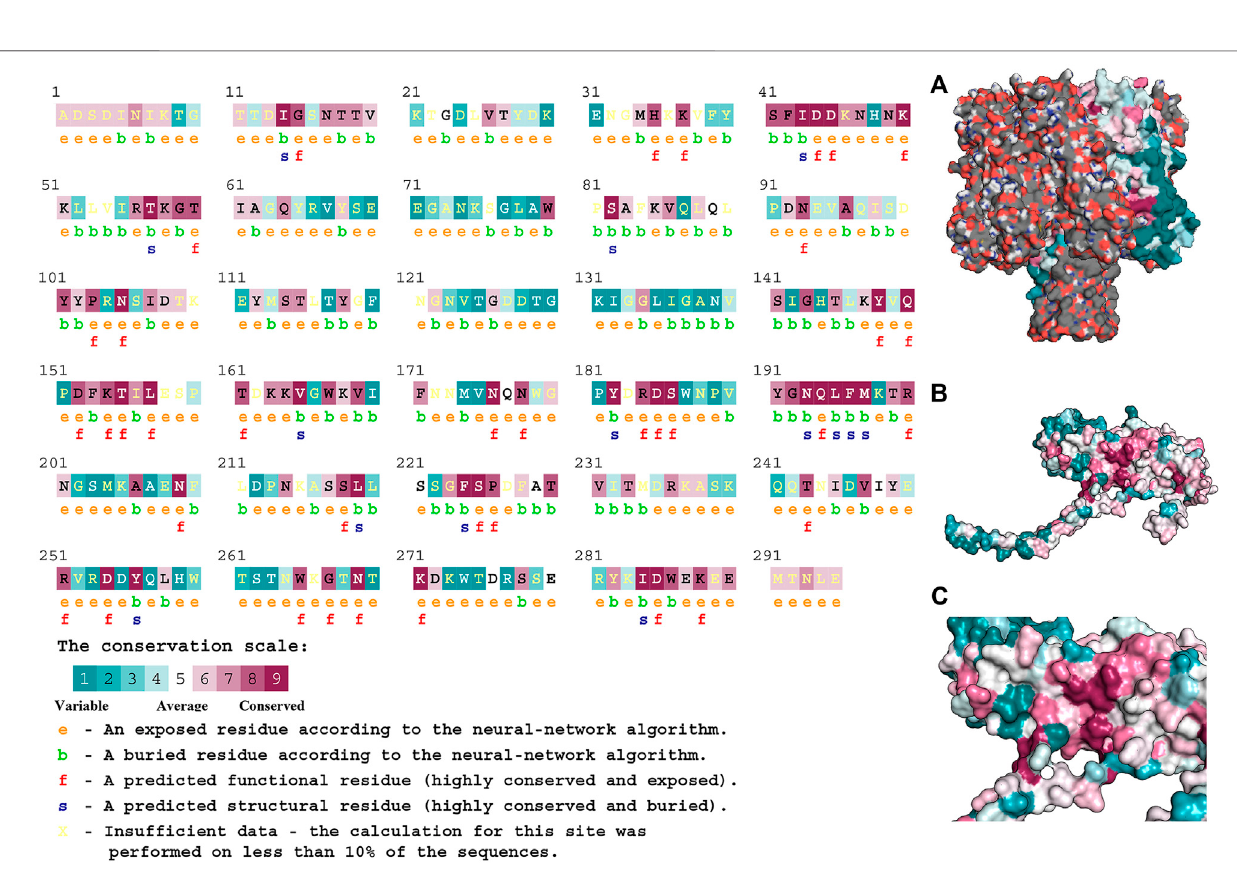
Frontiers in Pharmacology |